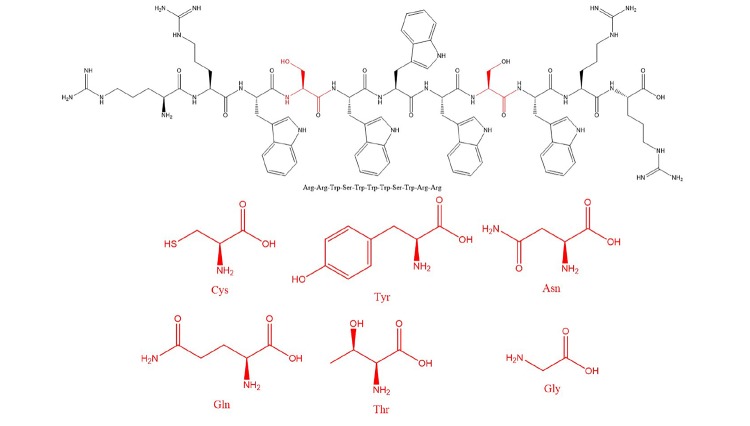
General schematic of designed peptides.